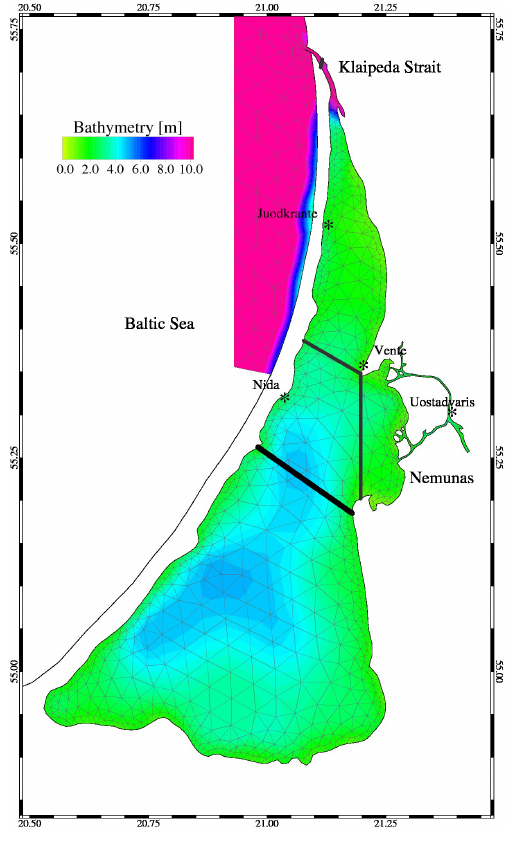
Figure 1. The setting of the Curonian Lagoon showing its bathymetry. Superimposed is the used numerical grid. The thick black line indicates the division into northern and southern sub- basin when computing the WRT. This section, called the southern section, is also used for computing the fluxes between the north and the south basins. The three thinner lines are the other flux sections and are named (from north to south) Klaip˙eda Strait, Vente, and Nemunas. An asterisk marks the stations where ice data have been measured (Juodkrant˙e, Nida, Vente,